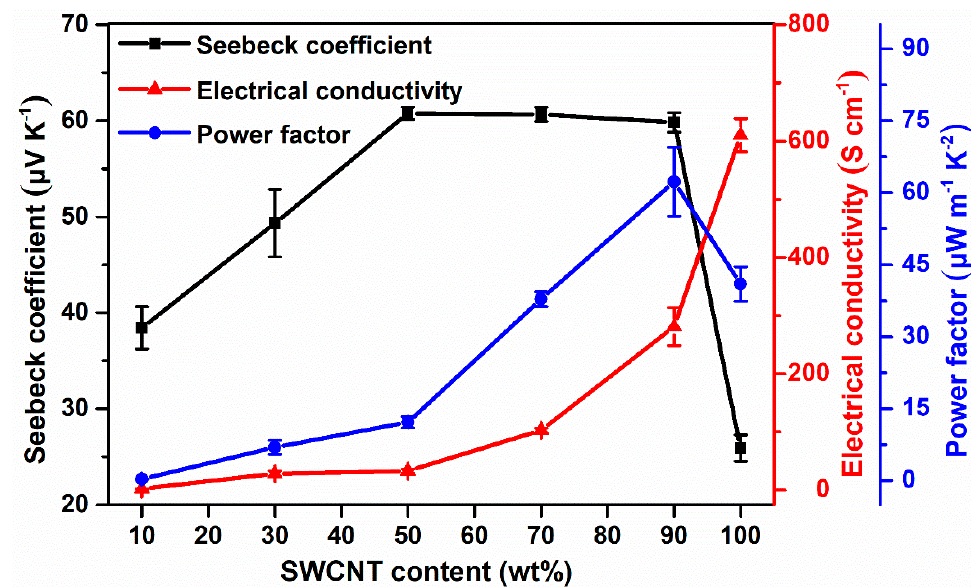
Figure 5. Electrical conductivities, Seebeck coefficients, and power factors at room temperature for the pure F8bpy/SWCNT composite films and pure SWCNT film. pure F8bpy/SWCNT composite films and pure SWCNT